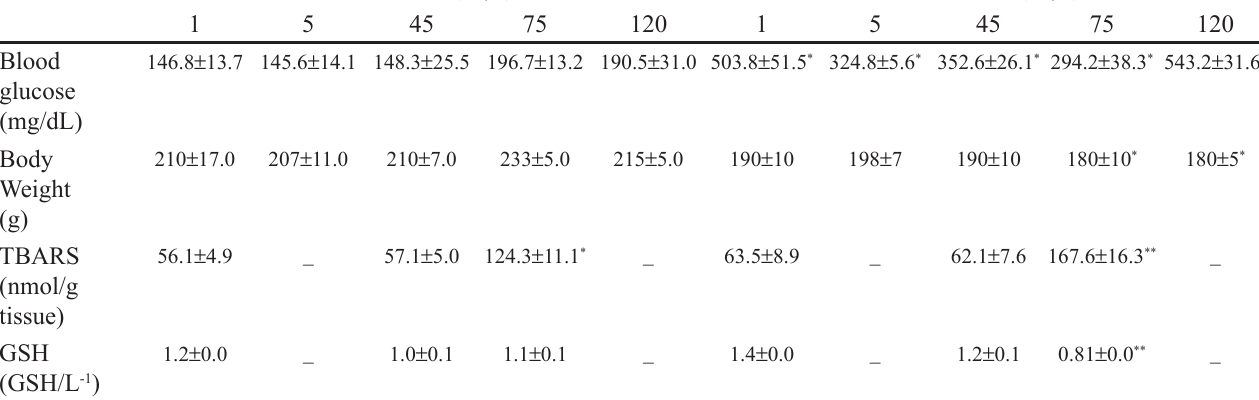
TABLE I - Glucose, body weight, oxidant and antioxidant parameters in the brain of premenopausal Wistar rats